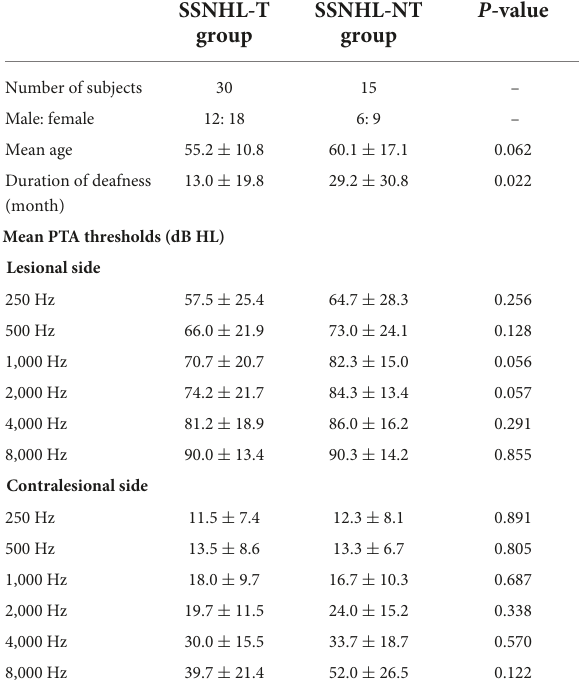
TABLE 1 Demographic and audiological characteristics of the study